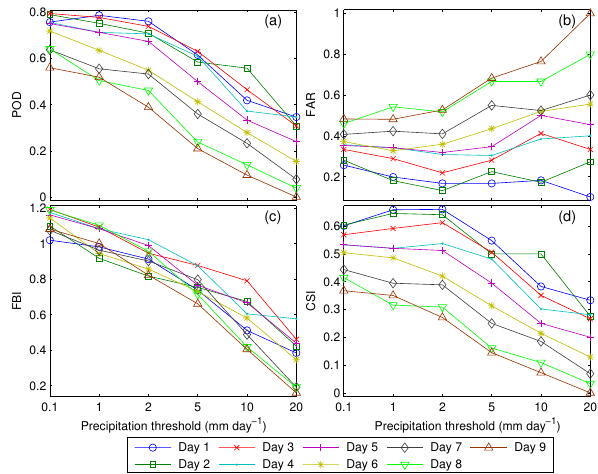
Fig. 9. Categorical evaluation scores of the ACCESS-G model for 24h accumulated precipitation forecasts as a function of precipita- tion threshold and lead time: (a) POD, (b) FAR, (c) FBI, and (d)